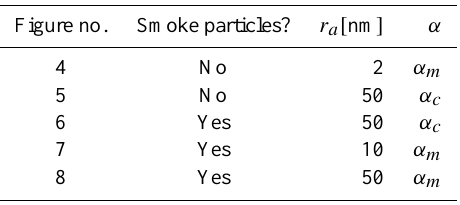
Table 1. Summary of model parameters used in the figures, where r a is the aerosol particle radius and α is the electron-ion recombi- nation rate coefficient. Figure